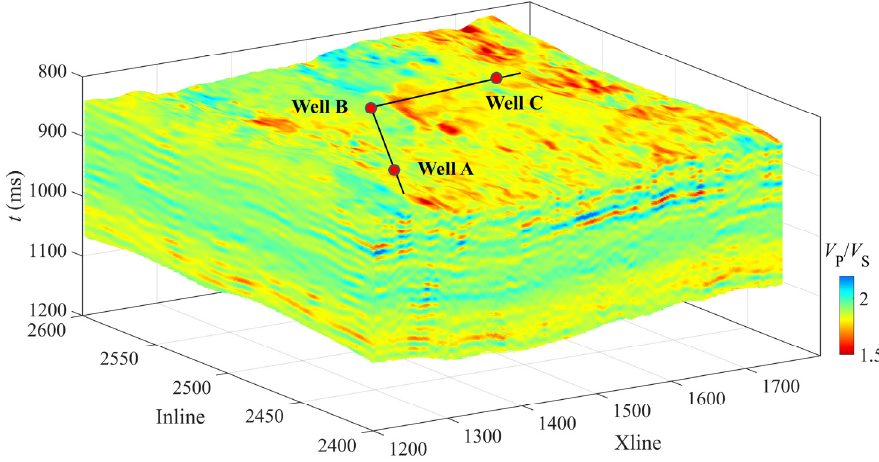
Figure 16. Seismic-inverted 3D cube of V P / V S in the tight sandstone formations in the study area.